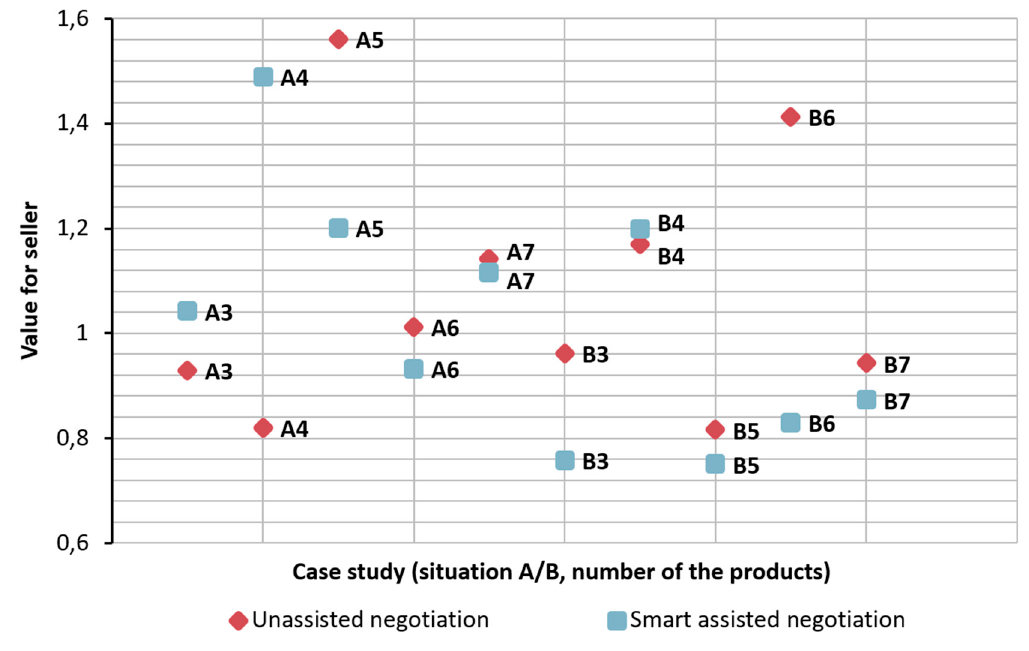
Figure 2. The ratio of costs and benefits for the seller.